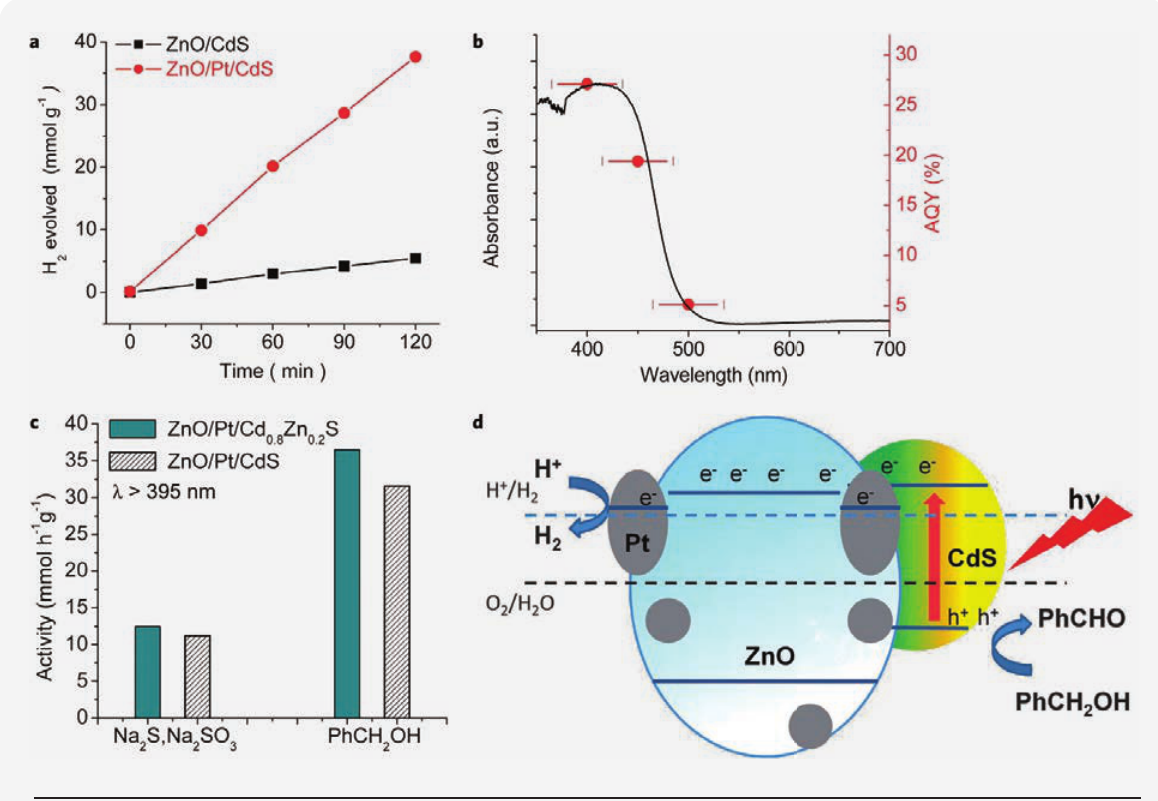
Figure 5. (a) Comparison of hydrogen evolution activity of ZnO/CdS and ZnO/Pt/dS. (b) Comparison of AQY with electronic absorption spectrum of ZnO/ Pt/Cd 0.8 Zn 0.2 S. (c) Comparison of activity obtained with Na 2 S-Na 2 SO 3 with benzyl alcohol and (d) schematic representation of process of hydrogen evolution on ZnO/Pt/Cd 0.8 Zn 0.2 S. Reproduced with permission from Ref.